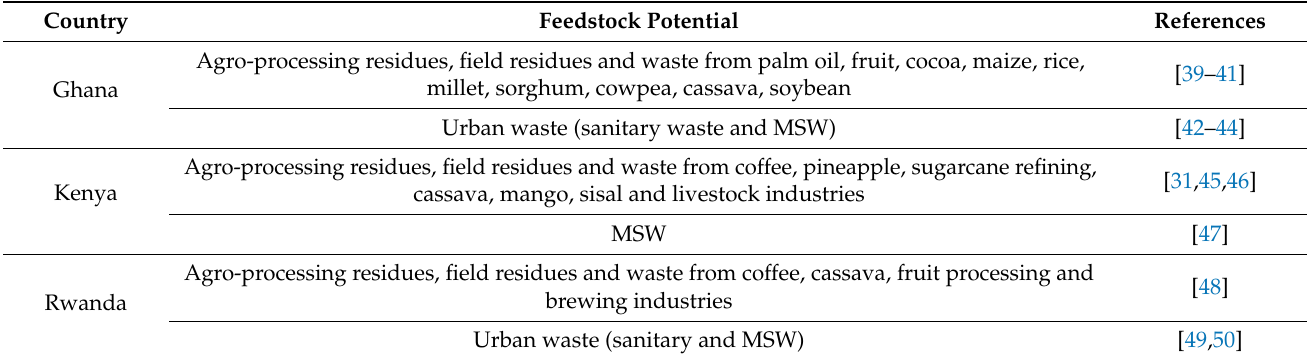
Table 3. Feedstocks reviewed for bioLPG production at scale in Ghana, Kenya and Rwanda. Country Feedstock